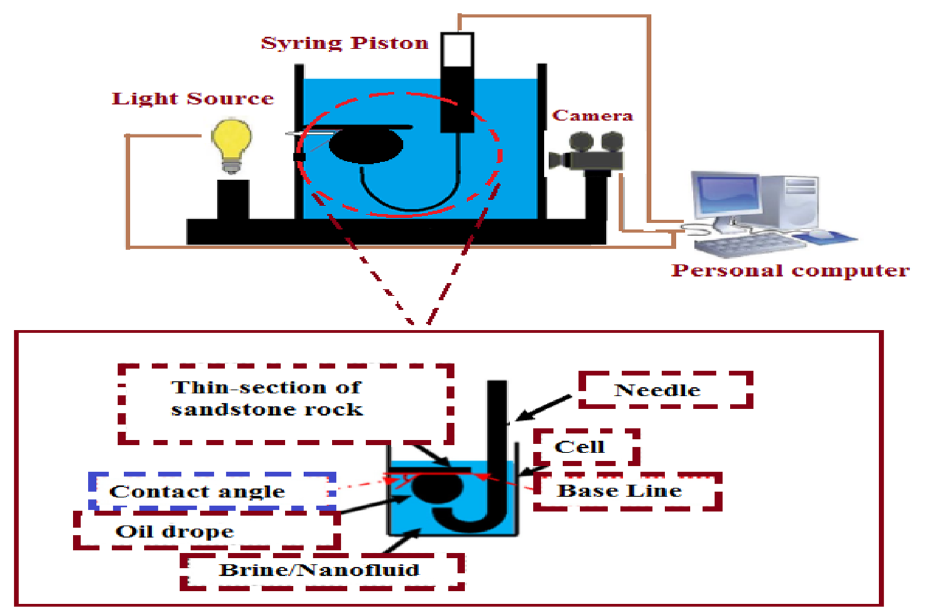
Figure 3. Schematic drop shape analyzer (DSA) diagram for contact angle measurement setup.